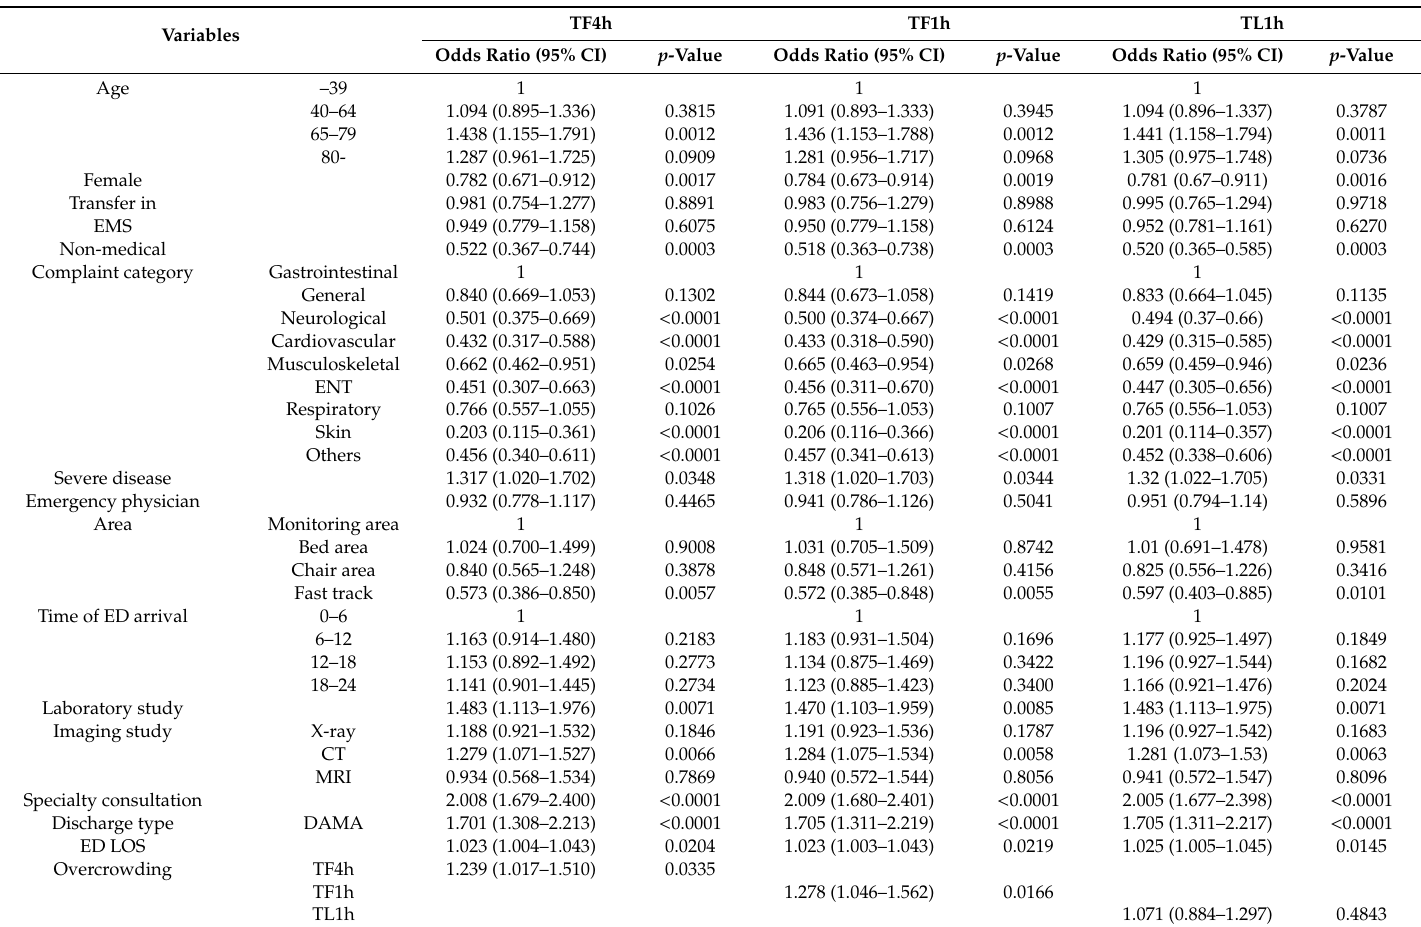
Table A6. Multivariable logistic regression of emergency department overcrowding of the number of total patients for return visit with admission.